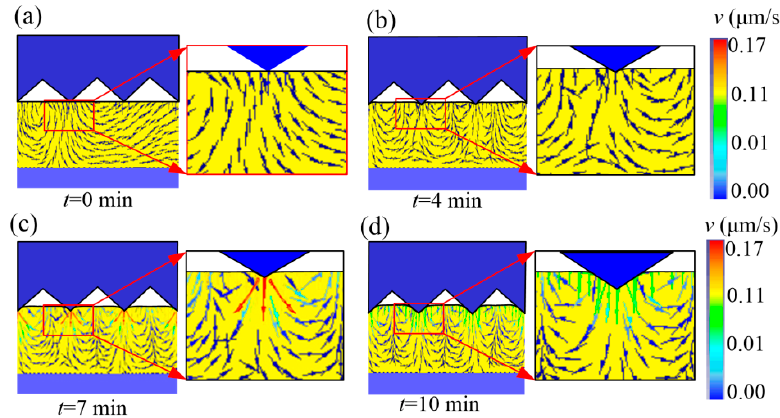
Figure 5. Flow-field distribution of microforming glass substrate. ( a ) flow-field distribution at t = 0 min; ( b ) flow-field distribution at t = 4 min; ( c ) flow-field distribution at t = 7 min; ( d ) flow-field distribution at t = 10 min.